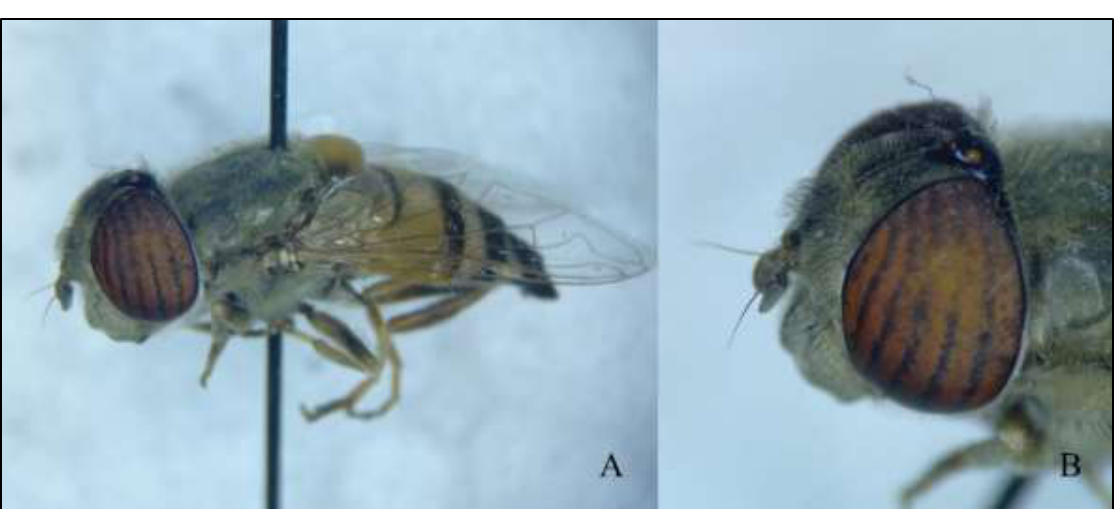
Figure 2. Eristalinus taeniops (Wiedemann, 1818): A − habitus of female, lateral view; B − head of female. (Photo: M. Vujić,